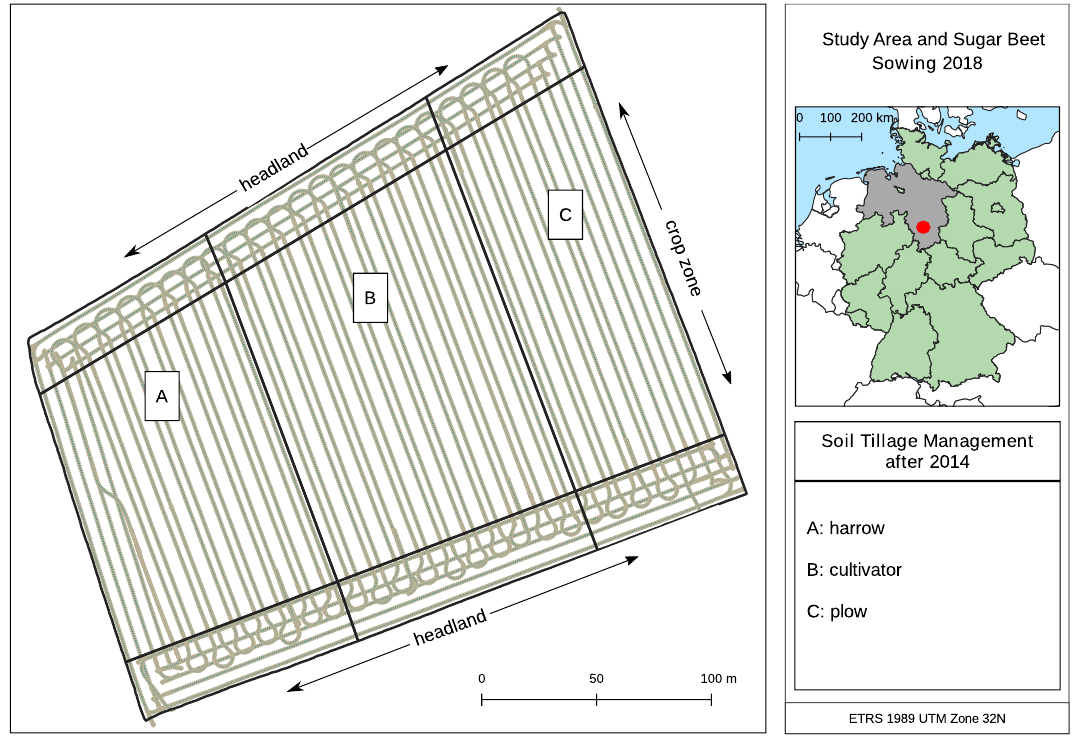
Figure 1. Study site and exemplary of the GPS-tracks (without adjustment of position) from sowing of sugar beet. The crop zone and headland are indicated by the arrows. On the front sides the headland is located transverse to the crop zone. The different zones marked A, B and C indicate the three types of soil tillage